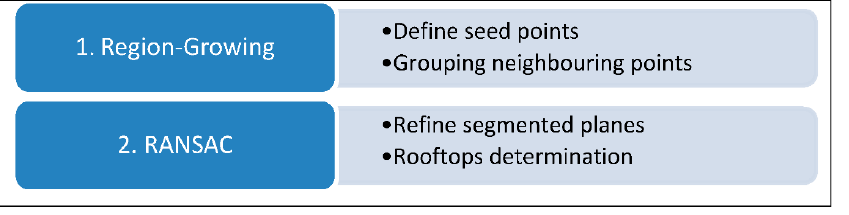
Figure 4. Schematic representation of the steps of the region-growing segmentation approach described in Section 2.3.